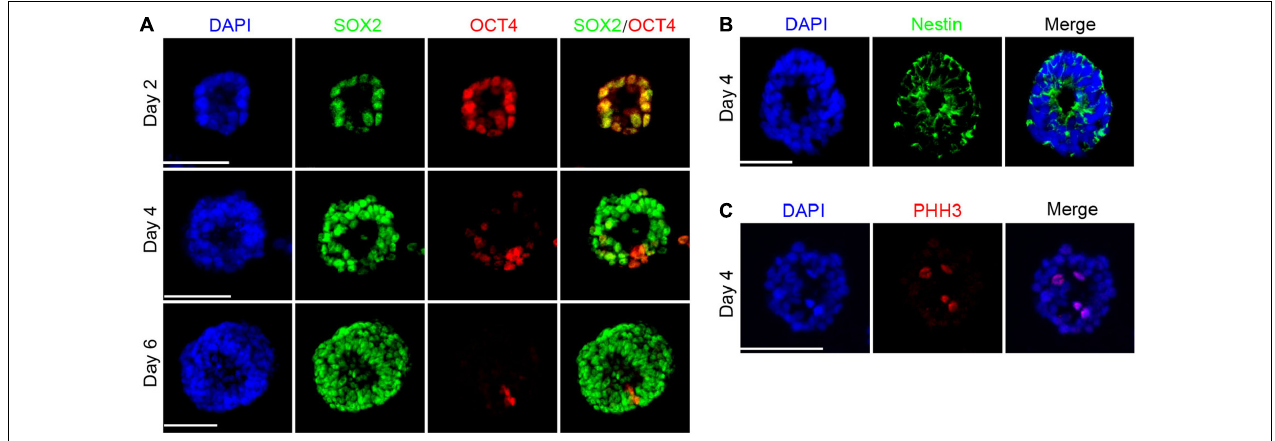
FIGURE 2 | The appearance of pseudo-stratified columnar epithelium during cell fate specialization. (A) The separation of SOX2 and OCT4 during the differentiation. (B) Neural rosette expressed Nestin by day 4. (C) Expression of PHH3 was rich at the apical area by day 4. Scale bars: 50 µ